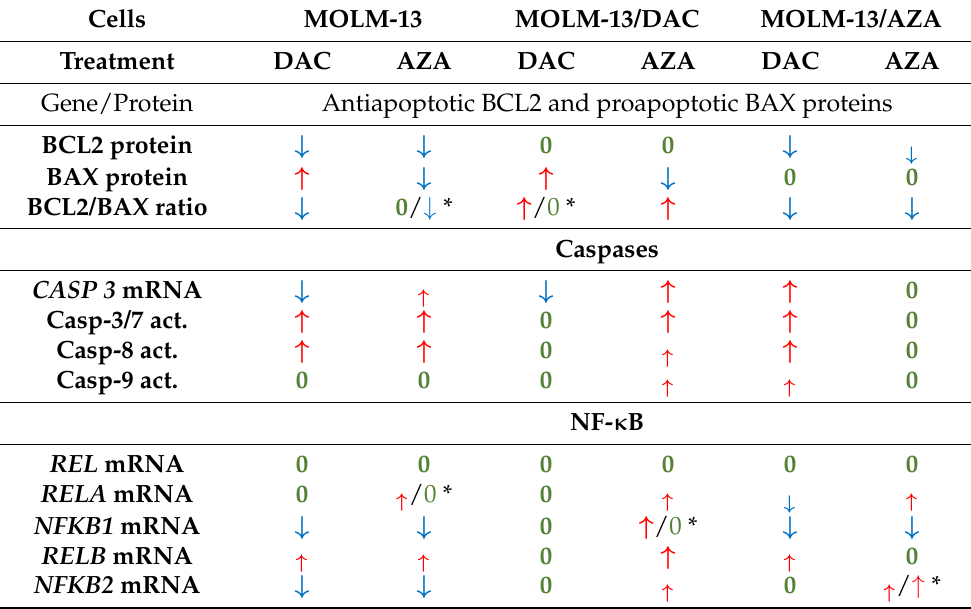
Table 3. Summary of the expression/activity of proteins active in apoptosis.